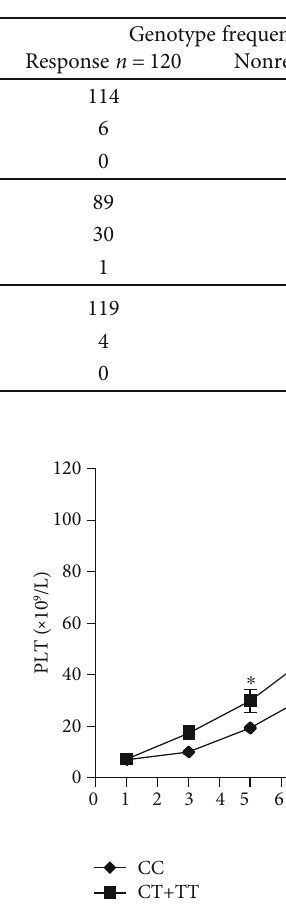
Table 3: The genotype distribution of rs117503120, rs5998634, and rs16866133 between the glucocorticoid response group and nonresponse group.